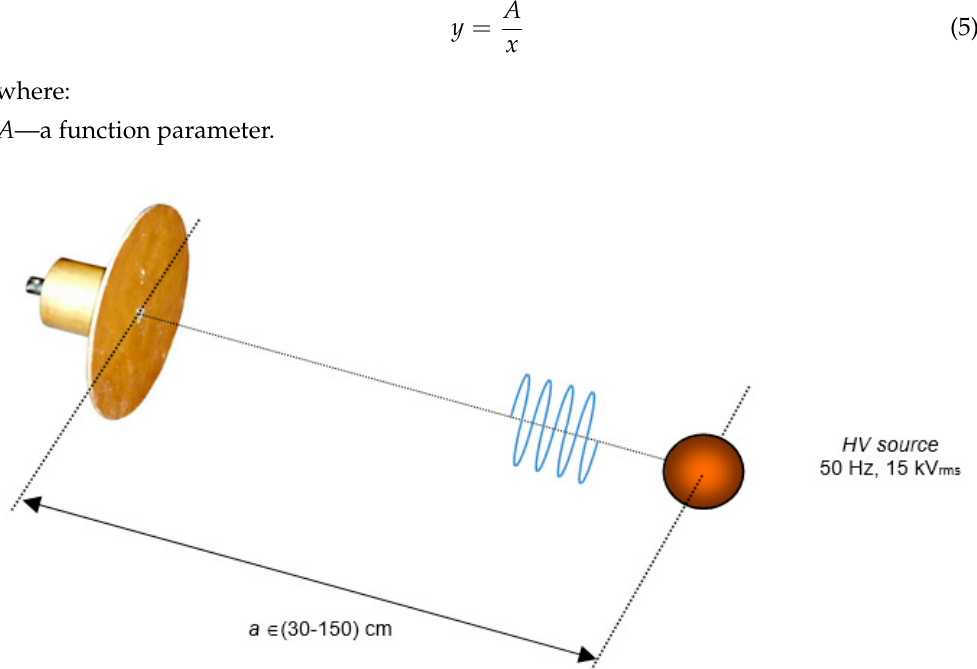
Figure 5. The method of determining the dependence of the amplitude of the signal registered by the sensor on the distance from the signal source.